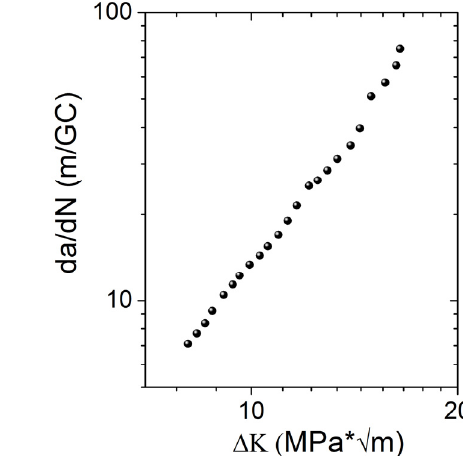
Figure 6: Raw fatigue crack growth data. Figure 7: Fatigue crack propagation curve.